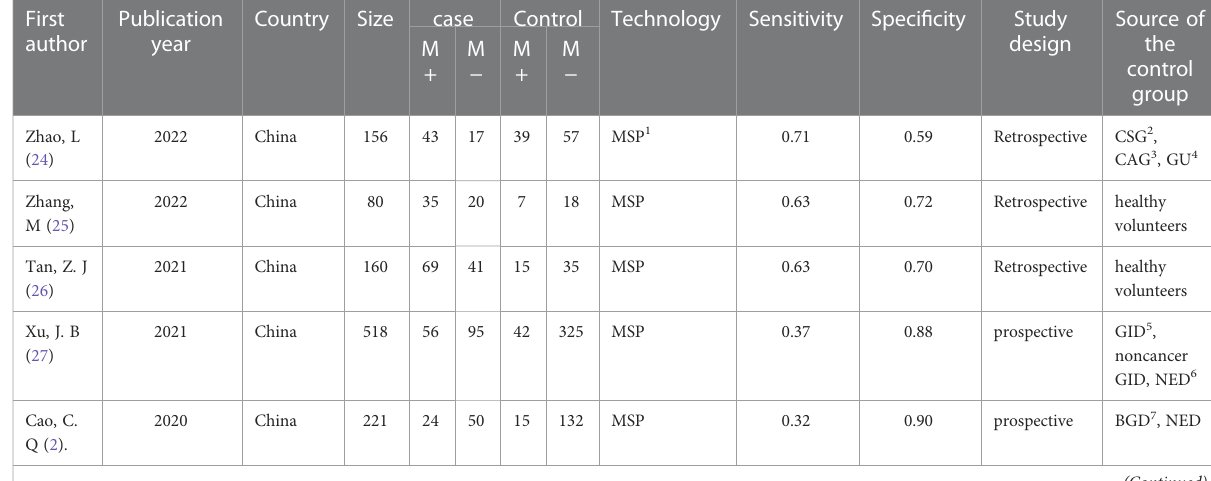
TABLE 1 Main characteristics of 9 studies included in the